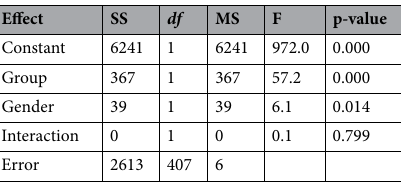
Table 3. The results of analysis of variance. SS sum-of squares, df degrees of freedom, MS mean squares.